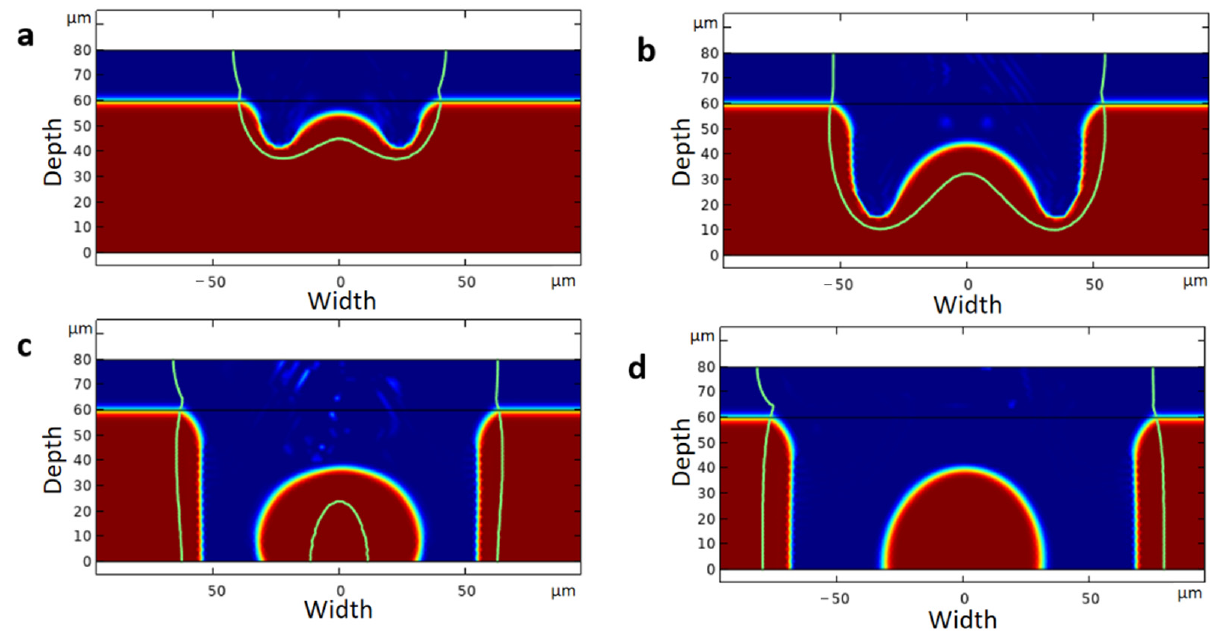
Figure 2. Phase transition process of the free interface of the titanium alloy micro hole with the laser processing time t . ( a ) t = 0.058755 ms; ( b ) t = 0.11994 ms; ( c ) t = 0.16412 ms; ( d ) t = 0.23016 ms.